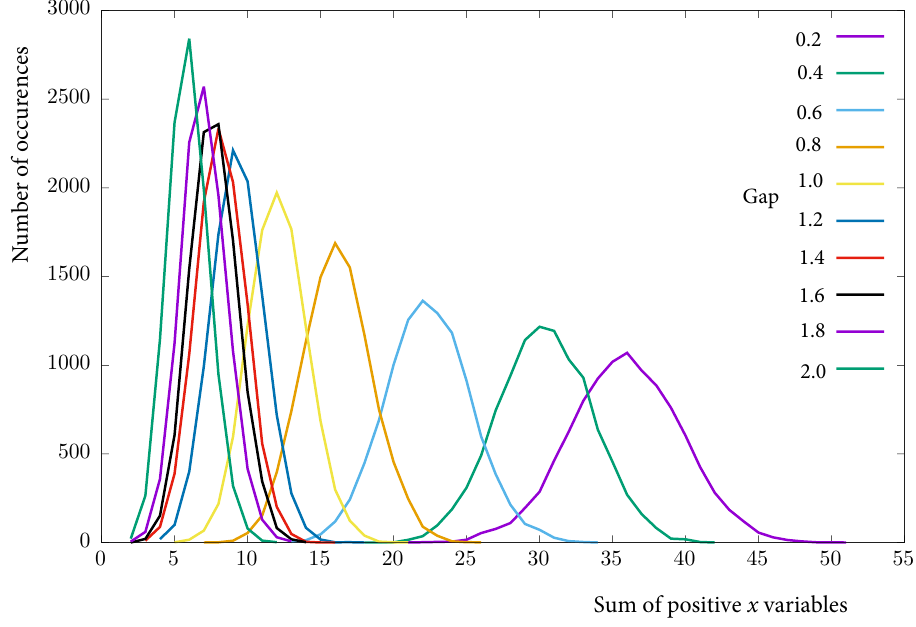
Figure 15. Dependence of the quality of the constraint embedding measured as the value of the sum of all x i (horizontal axis) on the value of the gap parameter, shown as curves of different colors. The vertical axis shows the frequency, or how many times, out of 10,000, the solution returned by the D-Wave annealer had the respective